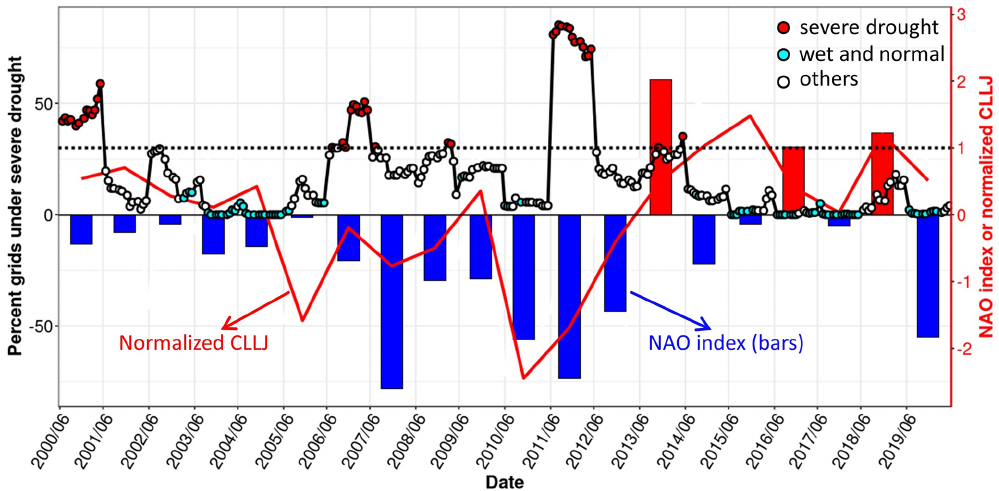
Figure 4. Time series of weekly regional dryness levels indicated by the percentage of grids under severe drought (D2–D4) in the southeast area (filled dots; left axis), the JJA-mean North Atlantic Oscillation (NAO) index (bars; right axis), and the normalized Caribbean low-level jet (CLLJ; red line; right axis). The dashed black line indicates the position of